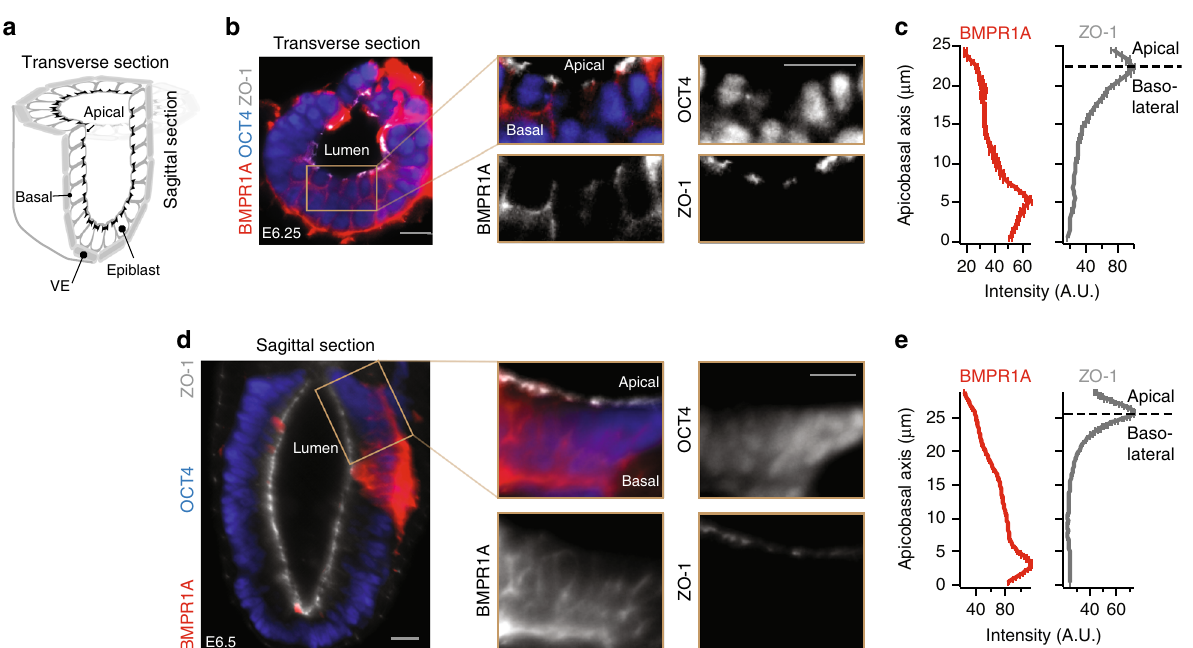
Fig. 4 BMP receptors localize at basolateral membrane of mouse epiblast in vivo. a Illustration of pre-gastrulation mouse embryo, showing transverse and sagittal sections. b Transverse section of an E6.25 mouse embryo stained for epiblast marker OCT4, BMPR1A, and ZO-1. c Plots of BMPR1A (left) and ZO-1 (right) staining intensity along apicobasal axis for transverse section from b show BMPR1A localized beneath tight junctions. d , e Same as in b , c but for a sagittal section of an E6.5 mouse embryo. These images are representative of two sets of images in two embryos/experiments. In mouse data, scale bar 20 µ m. Error bars denote